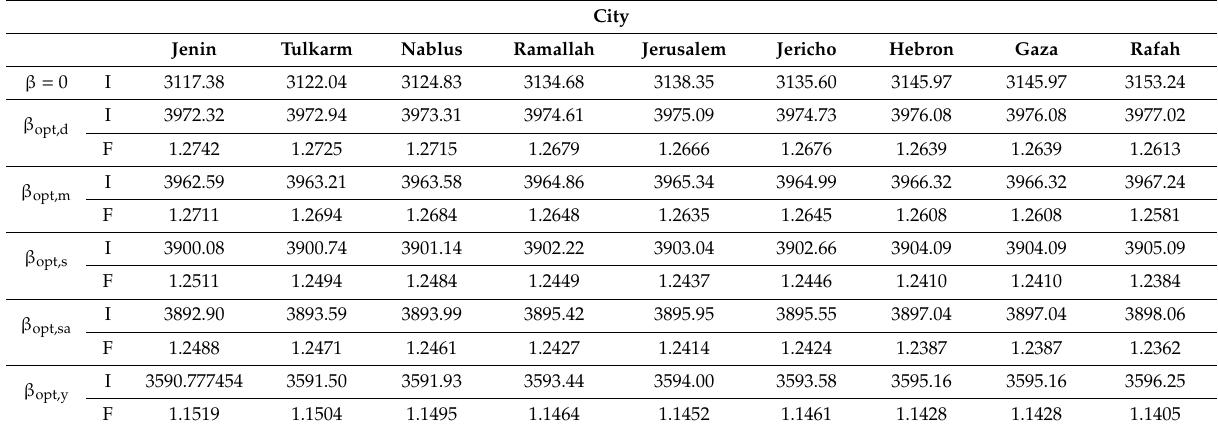
Table 7. The tilt factor for the daily, monthly, seasonal, semi-annual, and yearly optimum tilt angles for the main Palestinian